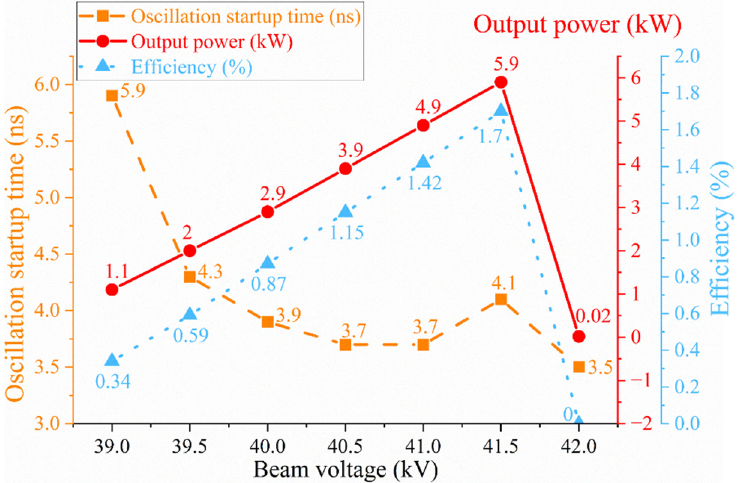
Figure 8. Oscillation startup time, output power, and efficiency are analyzed as a function of beam voltage.